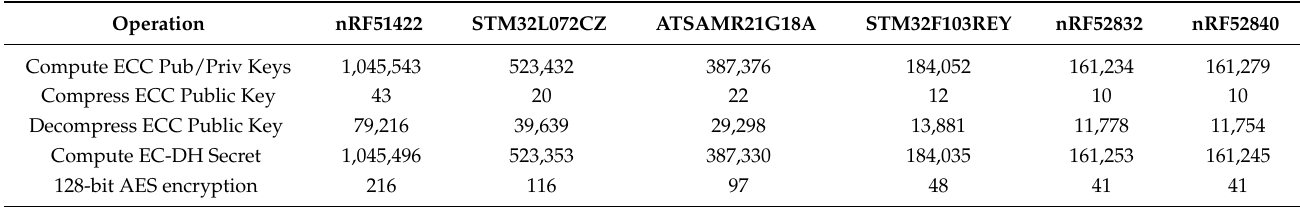
Table 8. Time consumption of each ECC operations and the encryption of a single 128-bits AES block (in